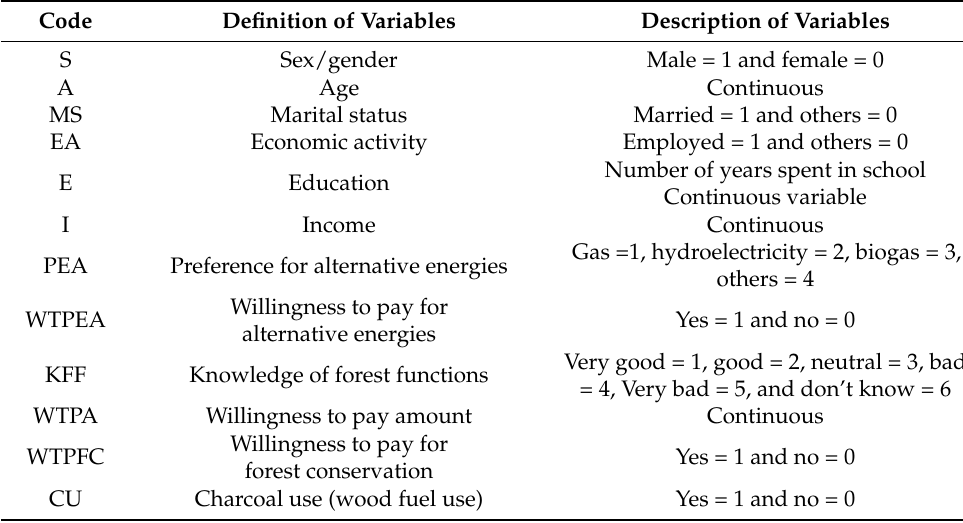
Table 1. Description of variables used in the study.